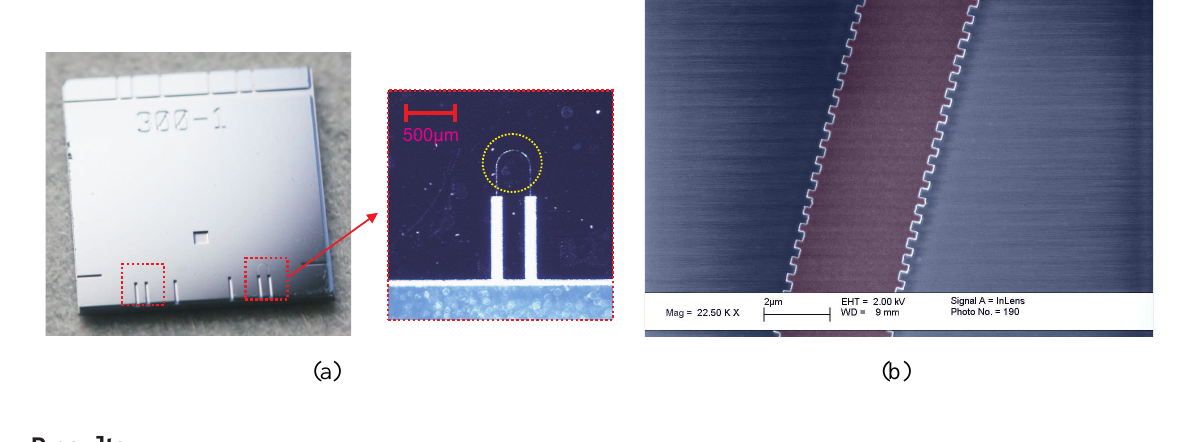
Figure 3. (a) Microscope images of a test chip with two sensors (marked with red dashed boxes). The test chip area is 1 × 1 cm 2 while the sensors occupy an area of 1 × 1 . 8 mm 2 . The membrane is not visible, but has been marked with a yellow circle on the close up of the sensor. (b) Color enhanced SEM image of part of the curved waveguide (purple). The Bragg grating is seen as corrugations in both sides of the waveguide. The period of the Bragg grating is 520